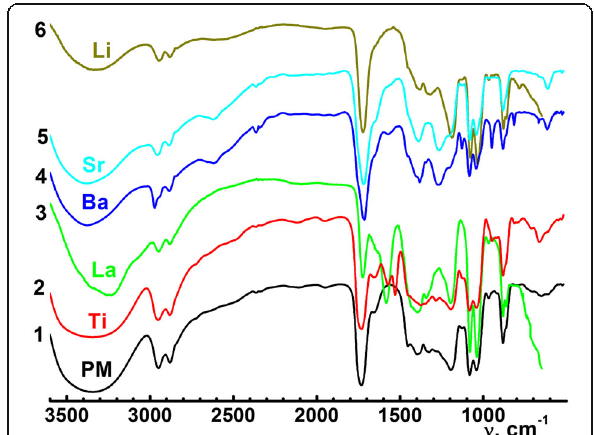
Fig. 2 FT-IR-spectra of polymeric matrix (1) and polymeric matrix with metal ions: Ti4+ (2), La3+ (3), Ba2+ (4), Sr4+ (5), Li + (6)